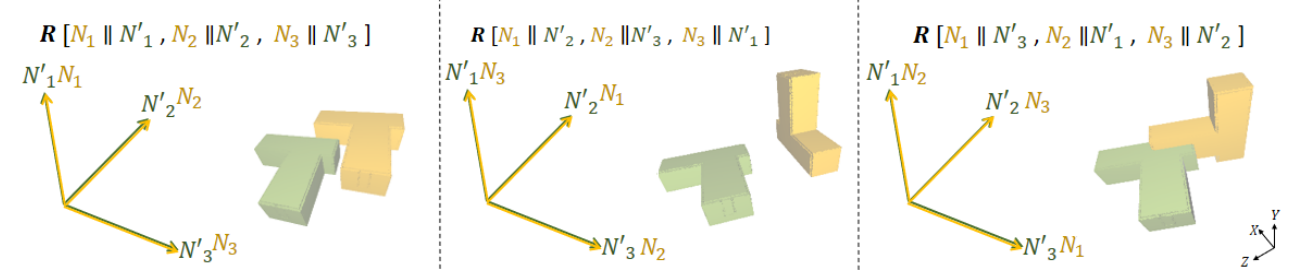
Figure 6. Example of a few rotation matrices and their respective rotational effect on the as-built model against the alignment of the as-planned model, obtained from different possible combinations by aligning the corresponding normal vectors of clustered segments from the as-built (yellow) and as-planned (green) models.